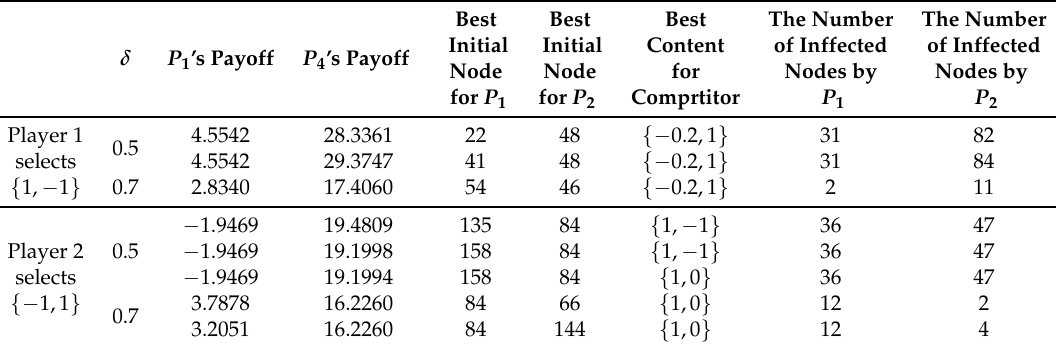
Table 6. Nash equilibrium when at least one of the players selects fixed content.